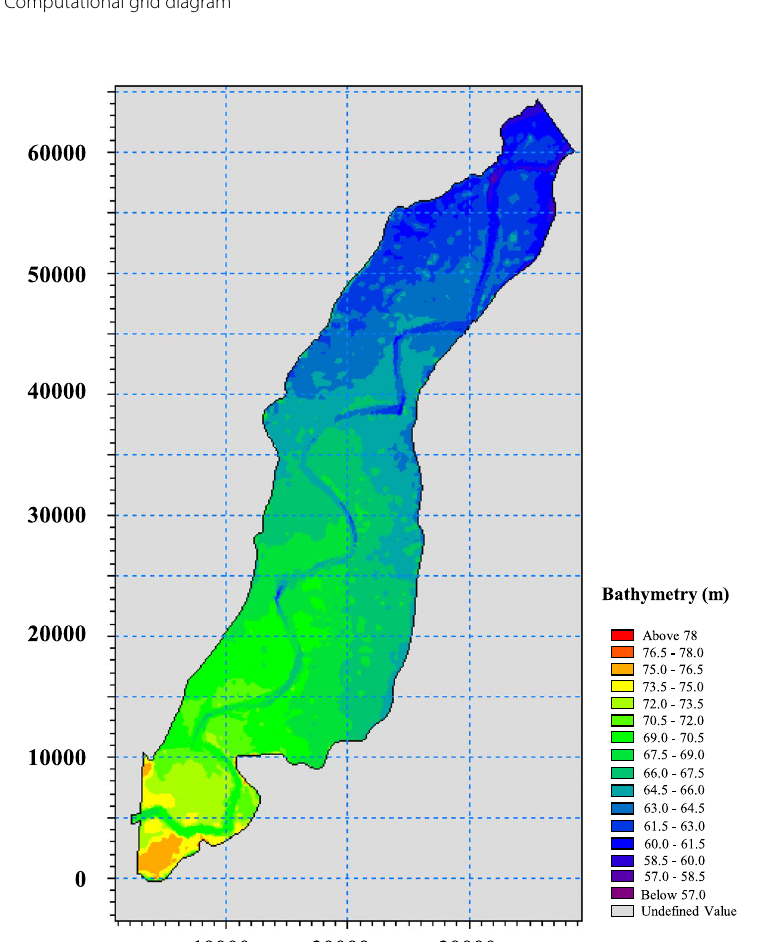
Fig. 2 Topographic map of the calculation